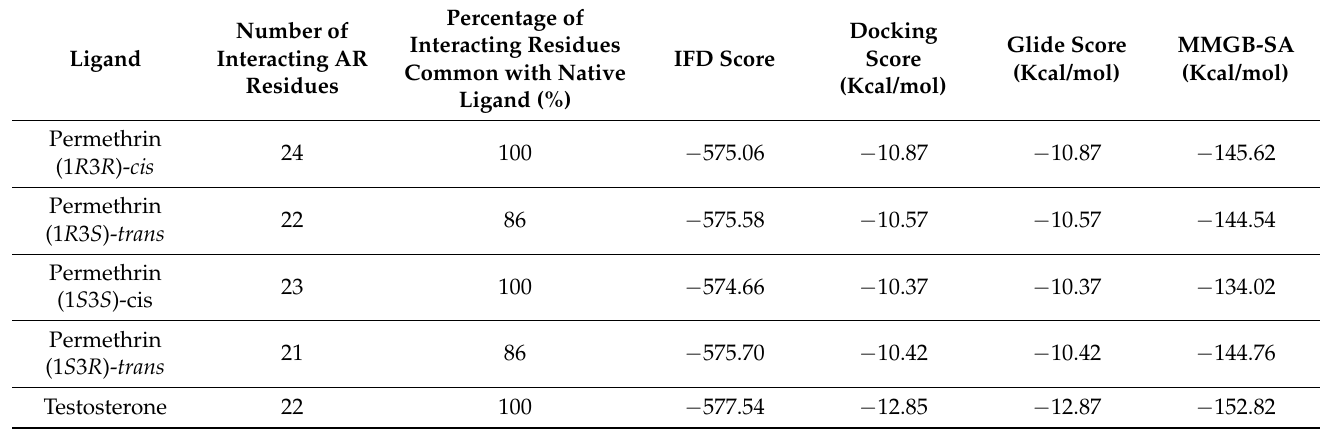
Table 1. Molecular docking parameters and binding energy values of four stereoisomers of permethrin, i.e., permethrin (1 R 3 R )- cis , permethrin (1 R 3 S )- trans , permethrin (1 S 3 S )- cis , and permethrin (1 S 3 R )- trans , and the androgen receptor (AR) native ligand,